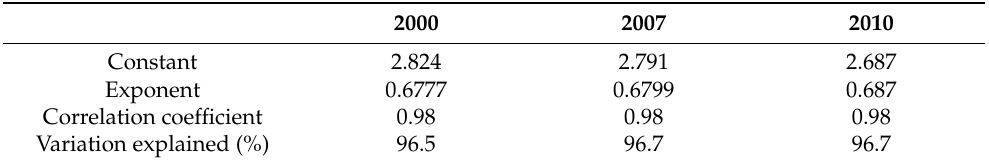
Figure 3. The power law relationship between total entrepreneurship and new entrepreneurship in 1785 U.S. counties in 2000. Table 8. Power law relationships between the total entrepreneurship and new entrepreneurship of 1785 U.S. counties in 2000, 2007, and 2010.